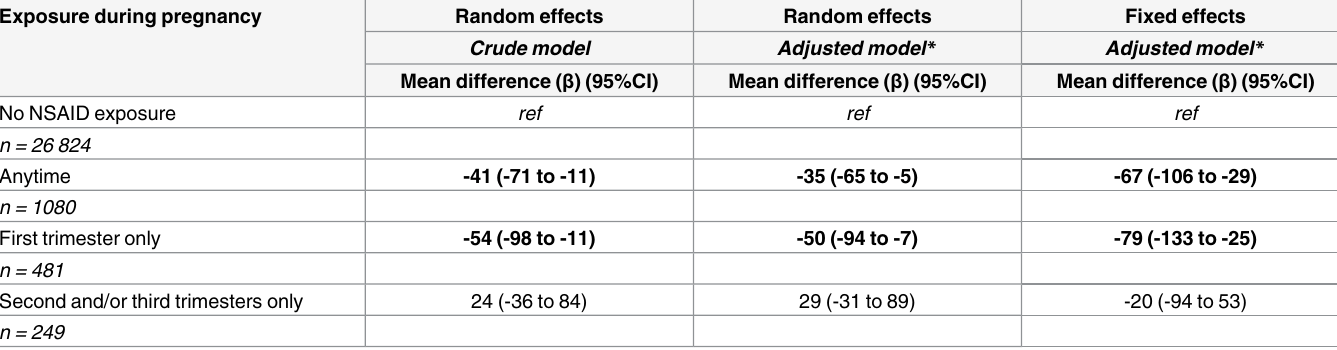
Table 3. Associations of ibuprofen with birth weight according to timing of exposure. All values are given in grams. Exposure during pregnancy